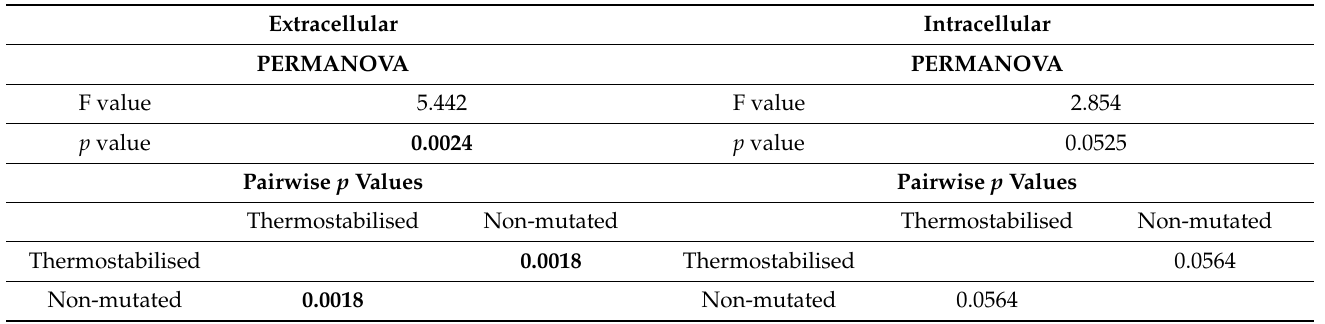
Table 9. A summary of PERMANOVA (distances) test data for the extra- and intracellular faces of the A2AR, β 1AR and β 2AR receptors, to support Figure 6; 9999 permutations performed on PC1-5, significant p values (<0.05) are shown in